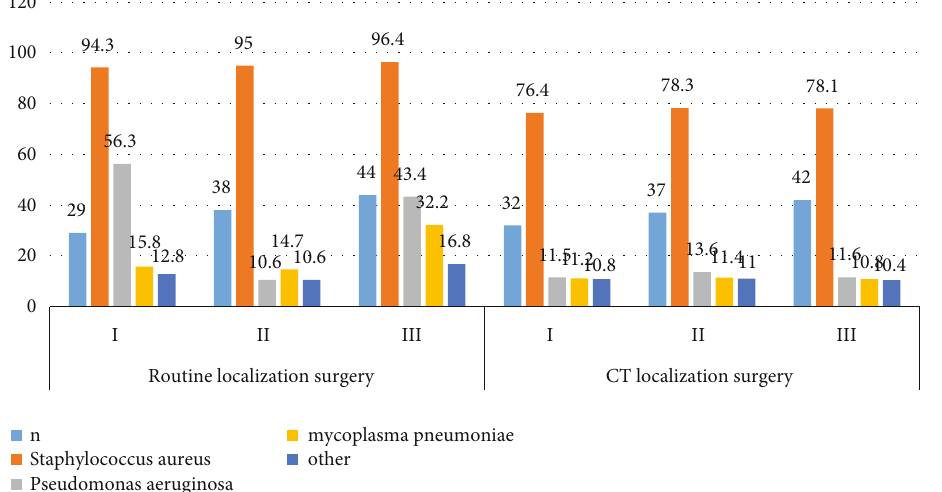
Figure 4: Comparison of the incidence rate of infectious